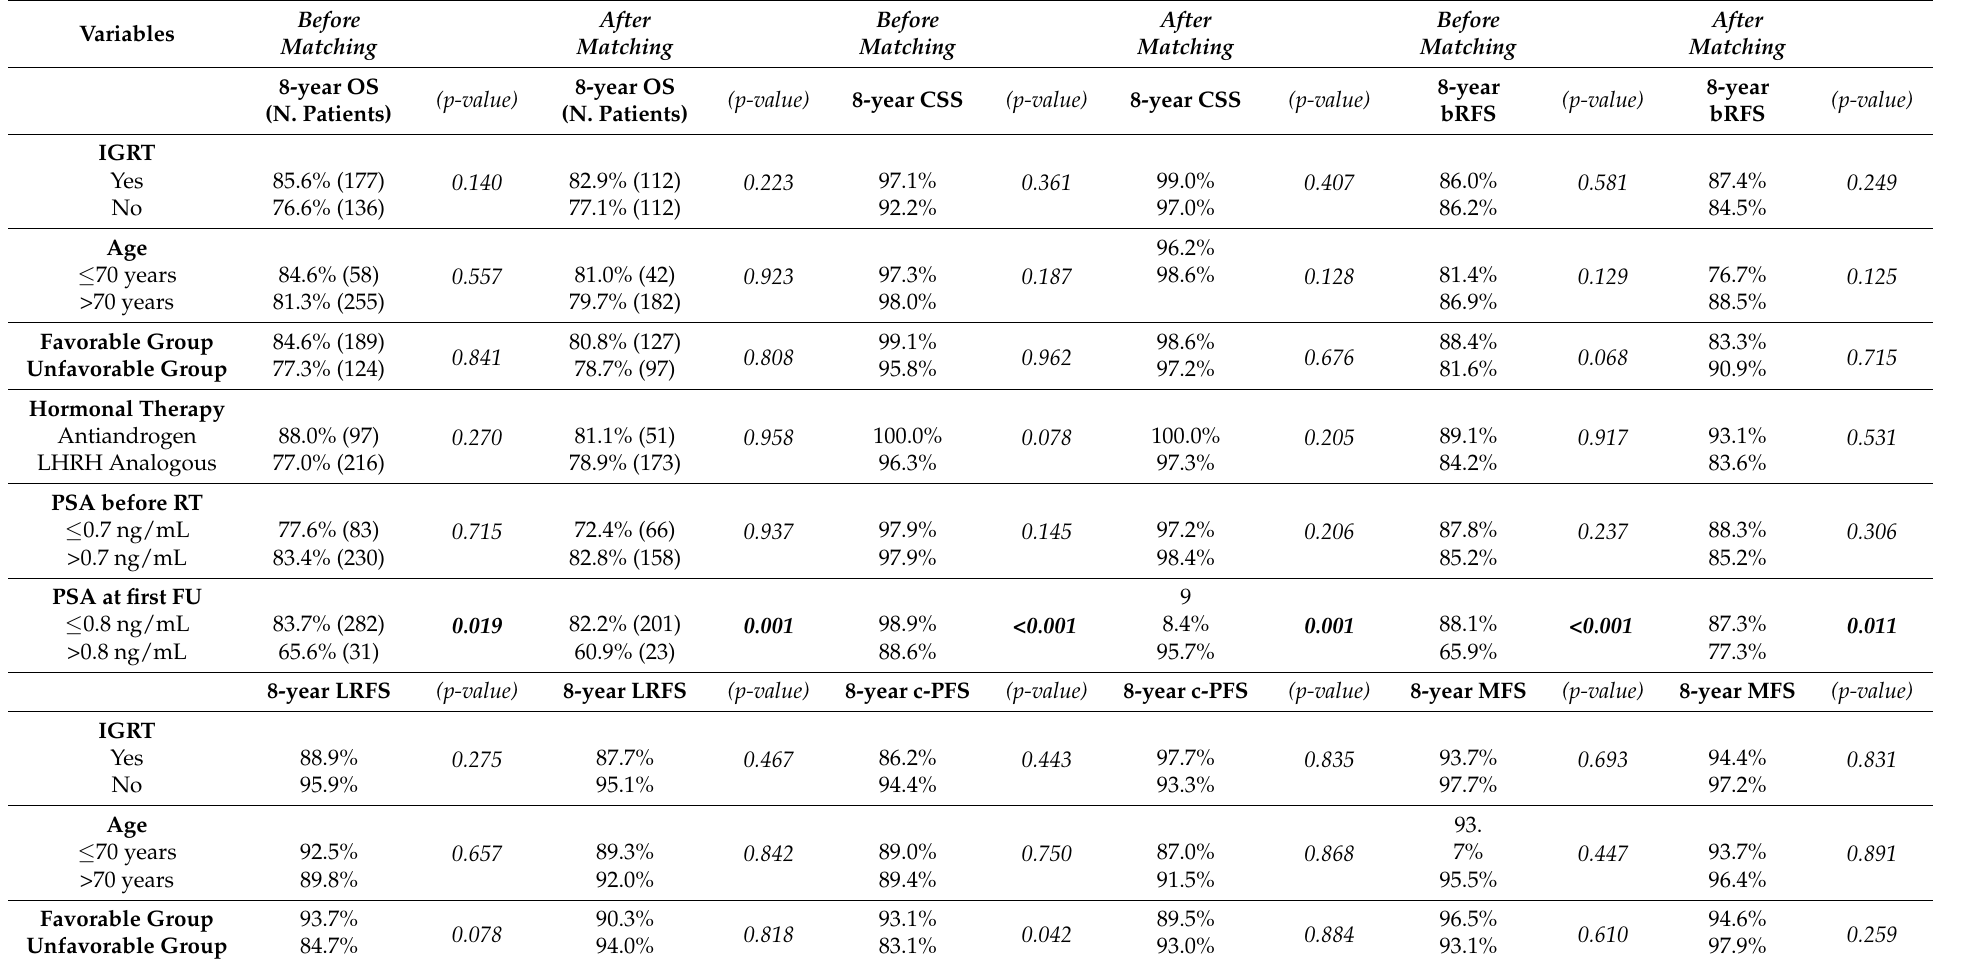
Table 3. Univariate analysis before and after propensity score